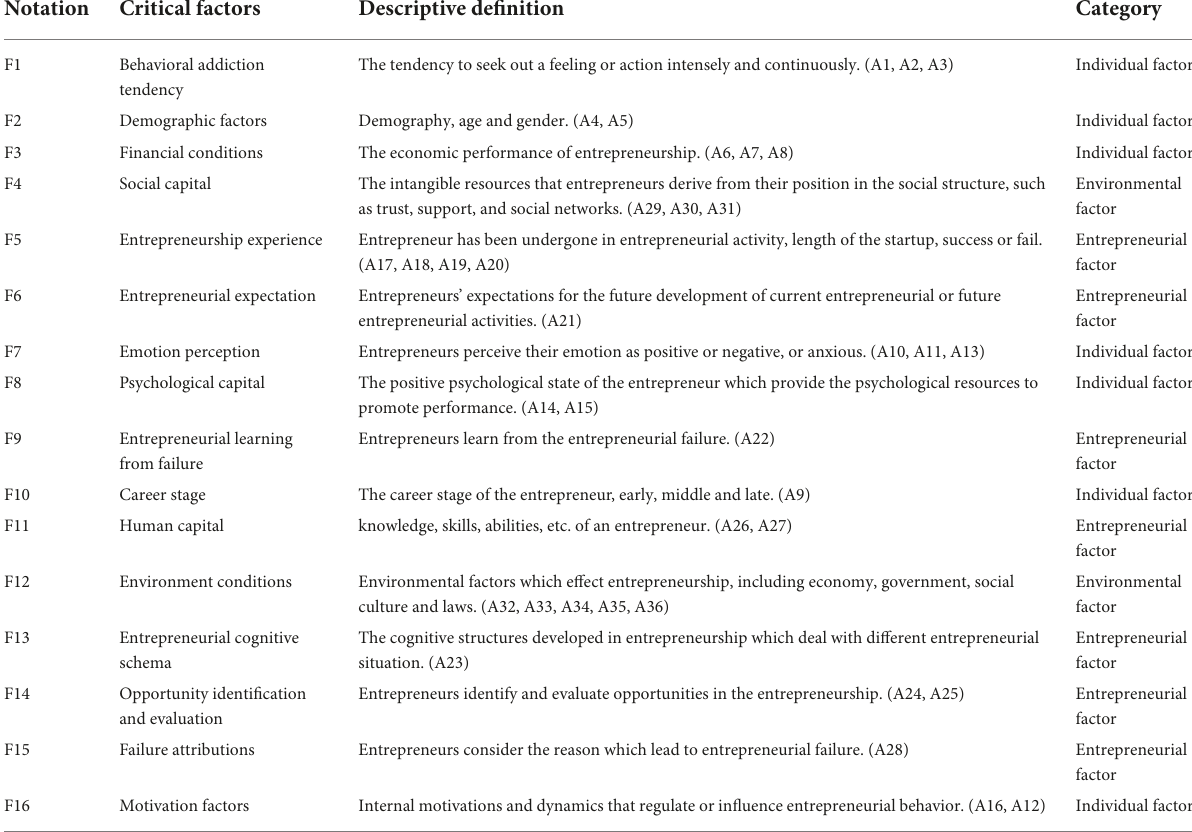
TABLE 2 Identified factors of serial entrepreneurial intention.